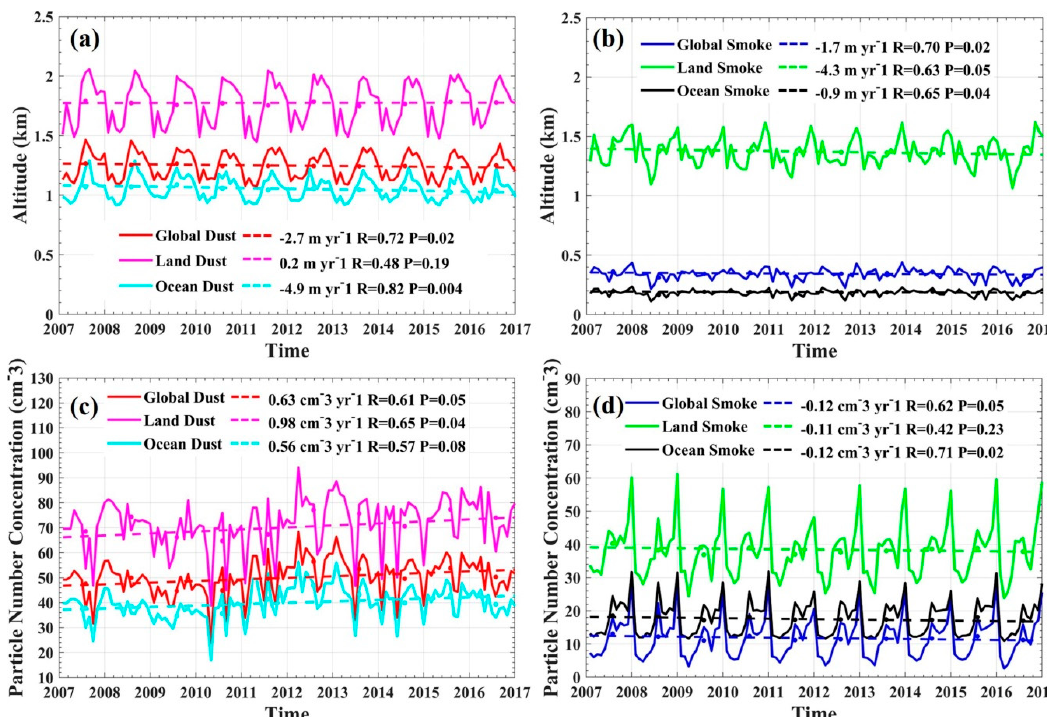
Figure 8. Variations in monthly (solid lines) and annual (circle points) mean MFA and MFNC values of absorbing aerosols from 2007 to 2016 for global, land and ocean. ( a ) MFA variations for dust; ( b ) Same as ( a ), but for smoke; ( c ) MFNC variations for dust; ( d ) same as ( c ), but for smoke. Remote Sens. 2020 , 12 , x FOR PEER REVIEW